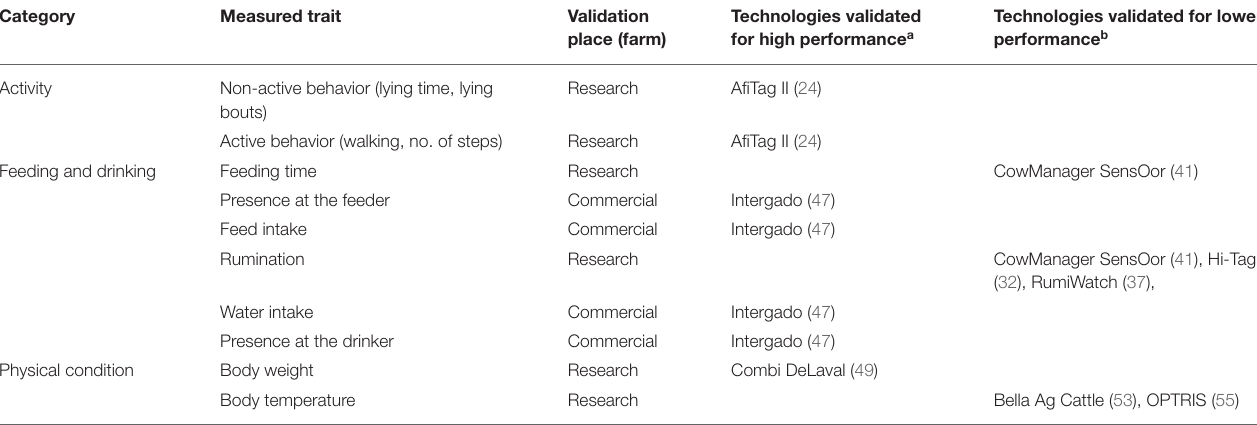
TABLE 3 | Results of validation trials for calves and heifers in respect to measured traits.